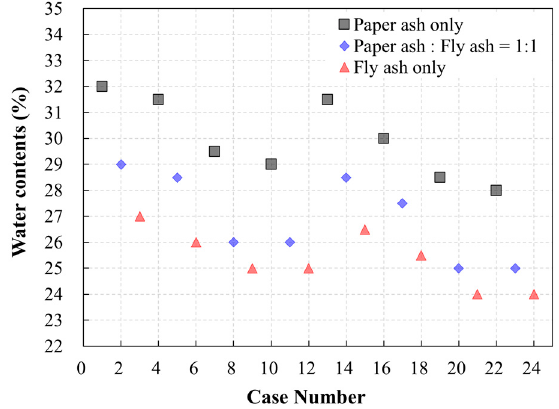
Figure 8. Water content required for adequate flowability.